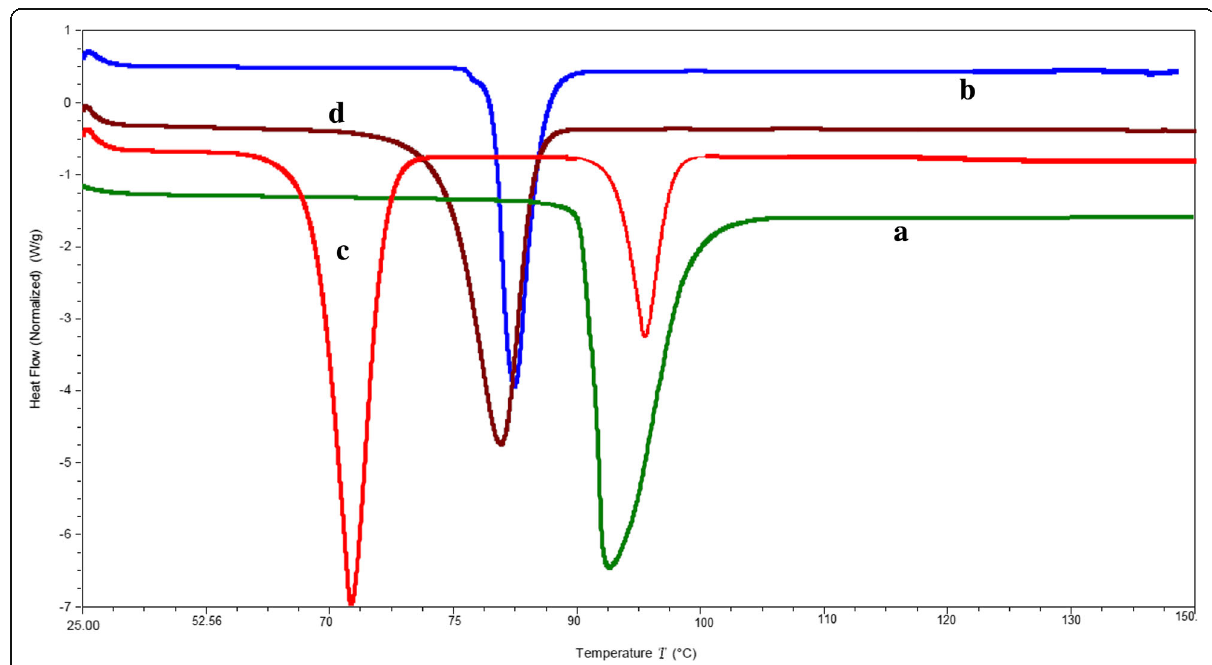
Fig. 3 DSC thermograms of pure ZT ( a ), pure Dynasan-118 ( b ), physical mixture of ZT + lipid (1:1) ( c ), and lyophilized optimized ZT-SLN (F1) formulation ( d